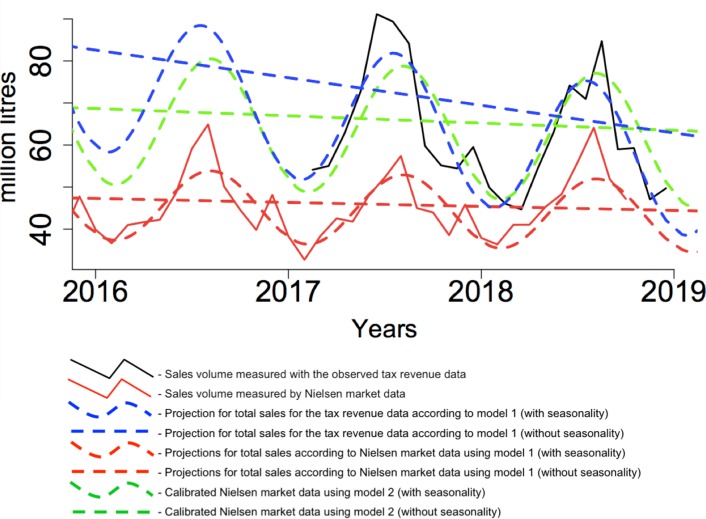
Time trend of total sales of sugar-sweetened beverages according to different data sources.Time trend of sales of sugar-sweetened beverages measured with the observed tax revenue data, only available post-tax (solid black line), and measured by Nielsen market data, available for the entire period 2016–2018 (red solid line); projections for total sales from the tax revenue data according to model 1 (dashed blue line with and without seasonality), projections for total sales according to market data using model 1 (dashed red line with and without seasonality); and calibrated Nielsen data from model 2 (dashed green line with and without seasonality). Dashed curves represent the data with seasonality, while straight lines represent the data without seasonality.